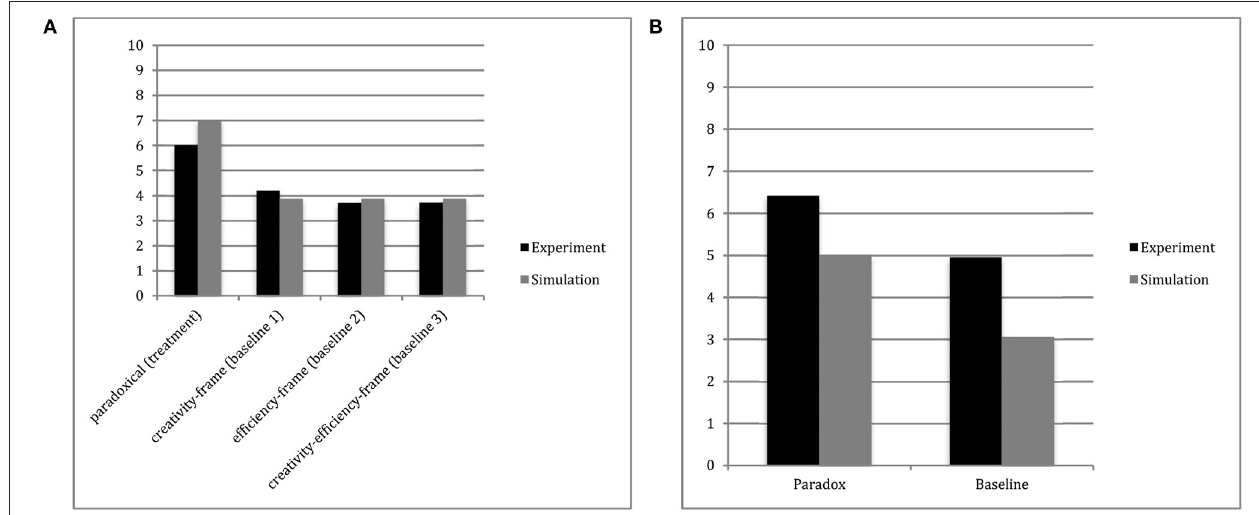
FIGURE 2 | Number of RAT problems correctly solved by condition. Simulated data from EII theory model and human experiment data from Miron-Spektor et al.’s (2011) Study 1 (A) and Study 2 (B) . The R-squared statistics for the fit between the simulated and human data was 0.997 for Study 1 and 1.000 for Study 2.